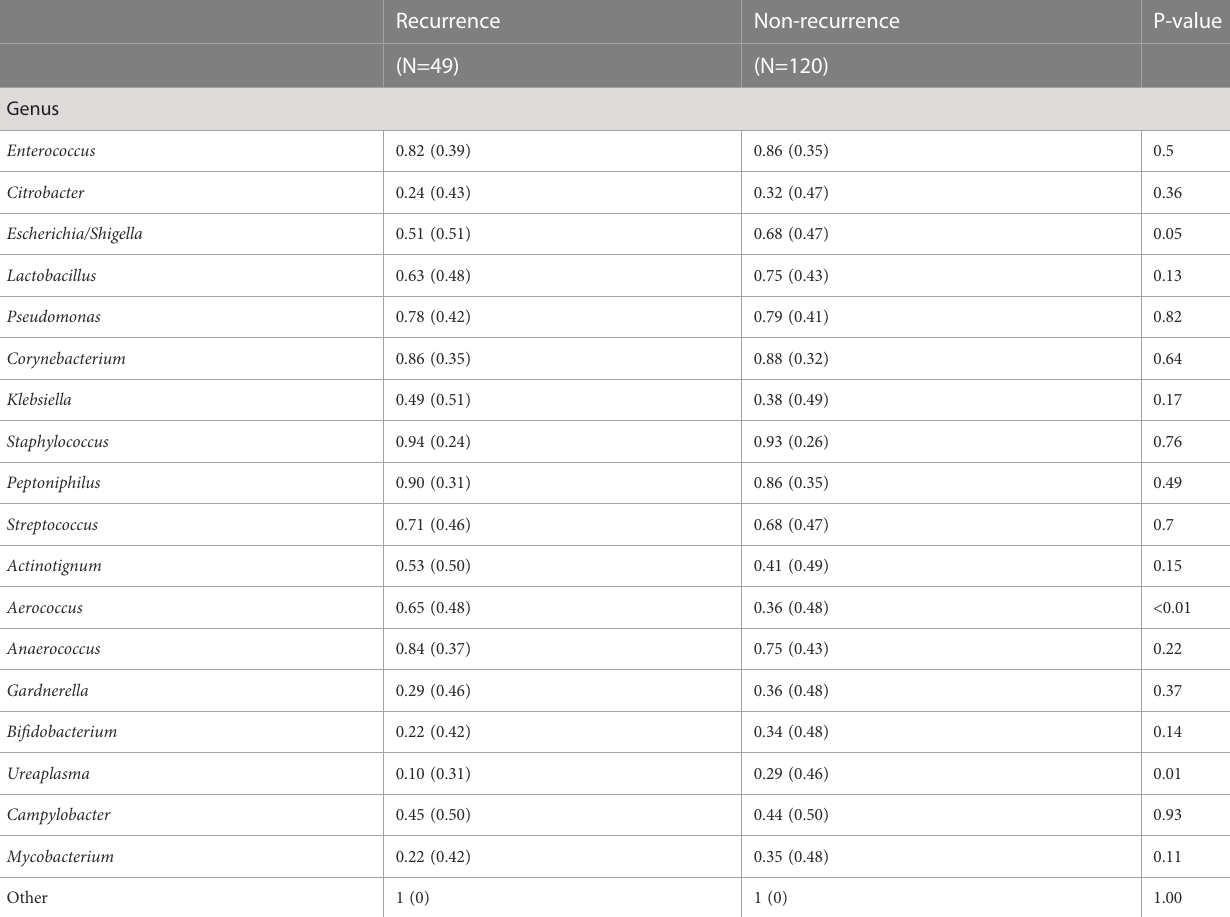
TABLE 5 Relative abundance of genera.